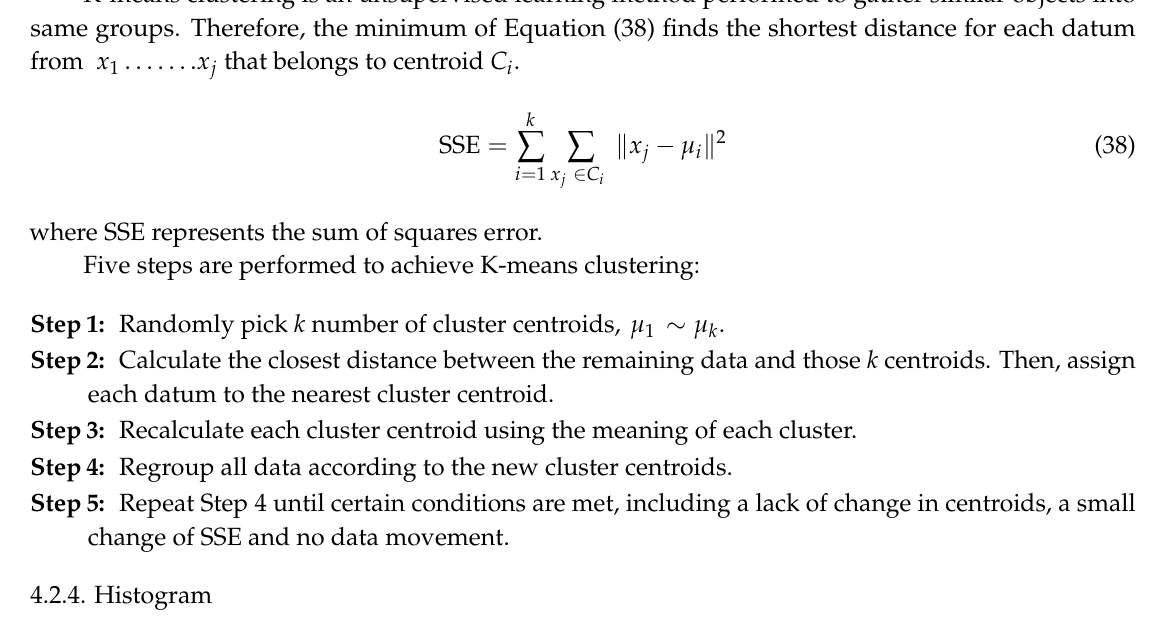
Figure 16. ( a ) Image gradient; ( b ) key point descriptor.